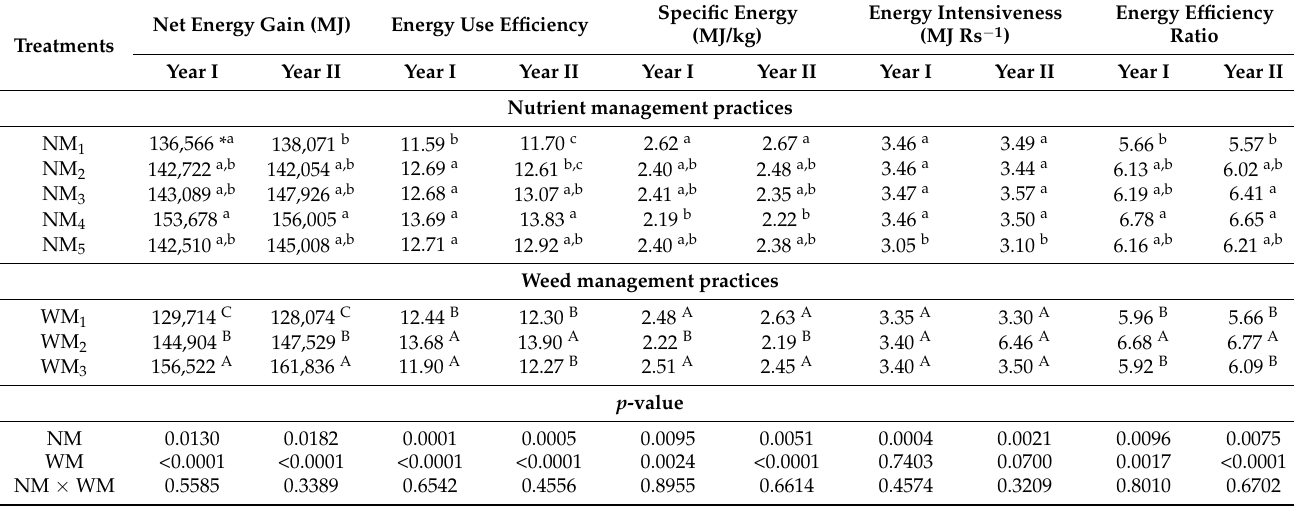
Table 6. Energy indicators in rice under the rice–maize–green gram cropping